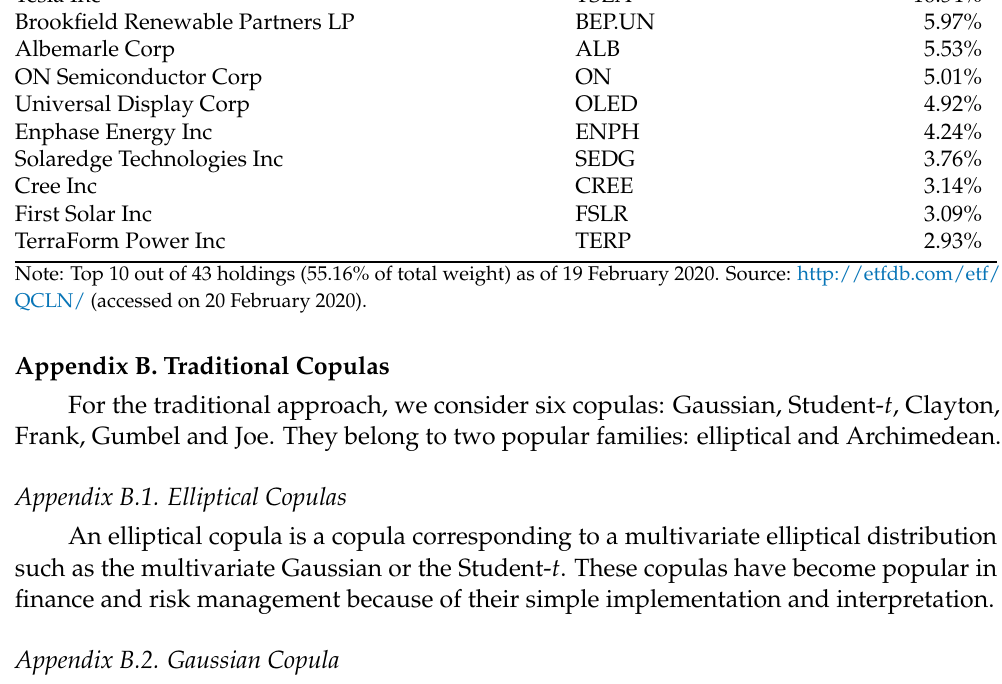
Table A3. First Trust NASDAQ Clean Edge Green Energy Index Fund (QCLN) holdings. Holding Ticker Weighting Tesla Inc TSLA Brookfield Renewable Partners